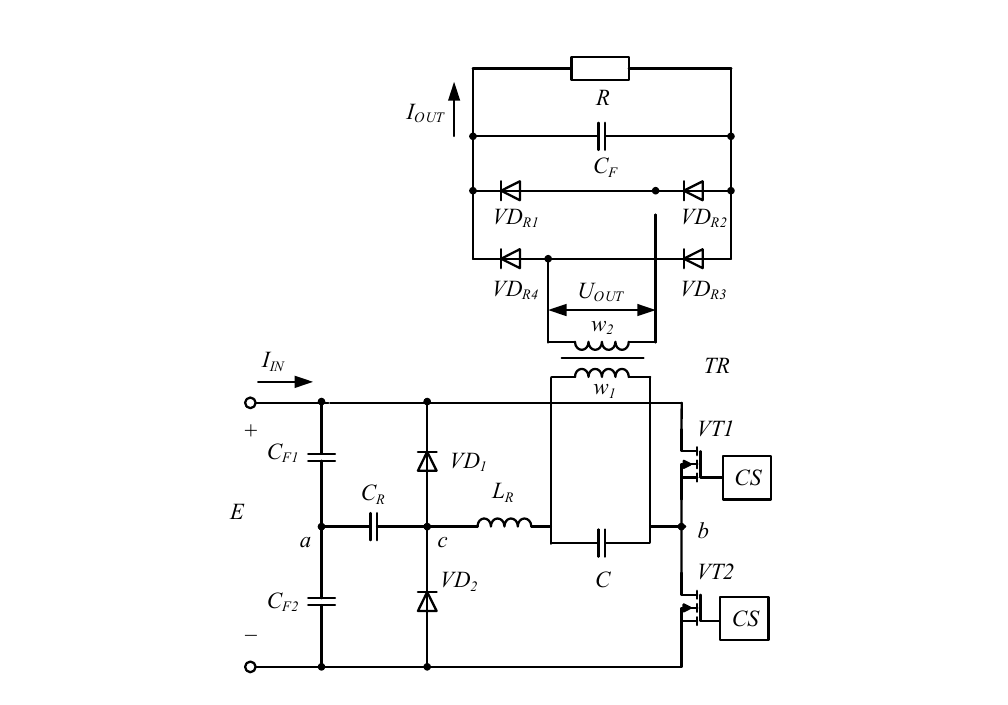
Figure 2. Basic timing diagrams of a half-bridge DC–DC converter with energy dosing.